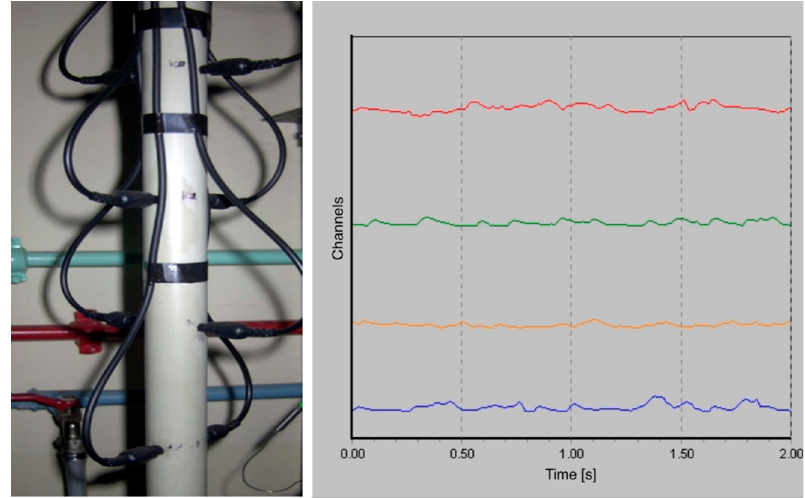
Figure 2. Light absorption measuring system.